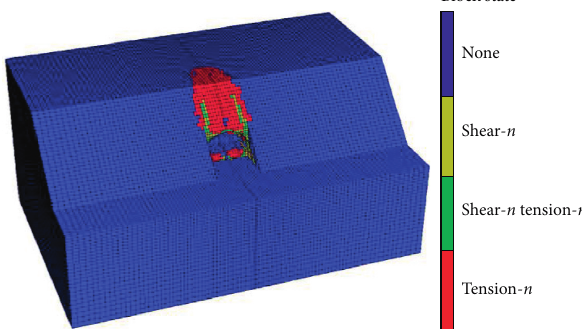
Figure 31: Plastic zone of the overlaying